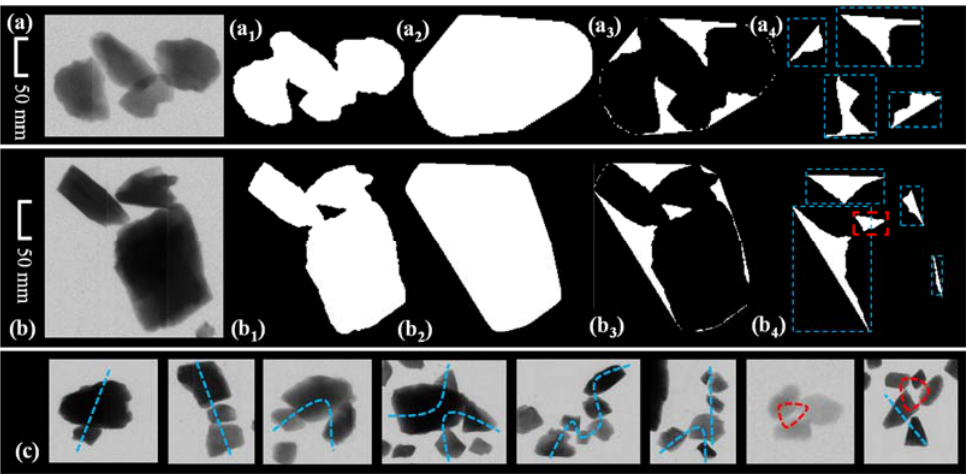
Figure 3. Types of adhesion and concave defects: ( a ) Open ‐ loop adhesion (OLA), ( a 1 ) Binary image, ( a 2 ) Convex hull binary image, ( a 3 ) Concave defect binary image, ( a 4 ) Binary image of concave defect after deleting small area. ( b ) Closed ‐ loop adhesion (CLA), ( b 1 – b 4 ) Same as ( a 1 – a 4 ), ( c ) OLA, and CLA.